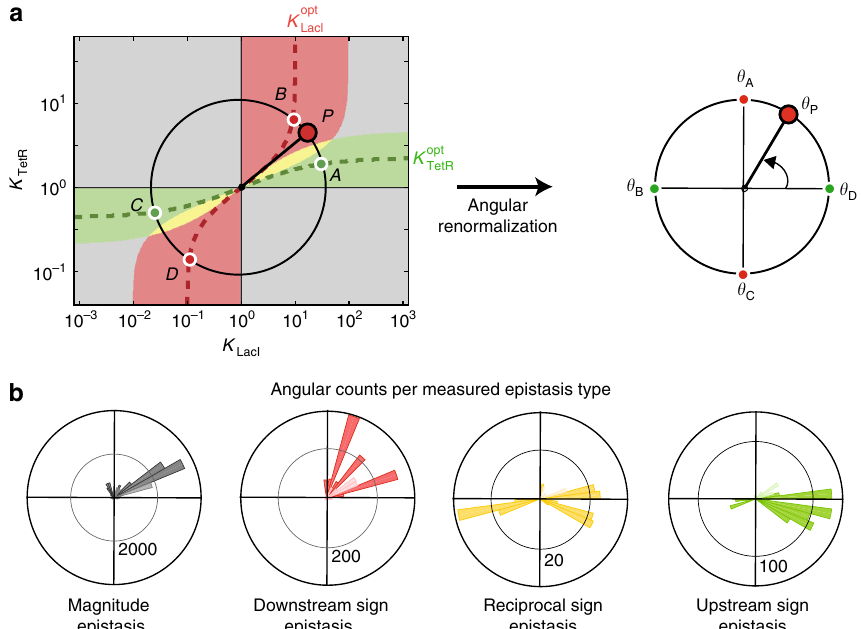
Fig. 4 Epistasis domain structure. The biochemical model and epistasis analysis (Fig. 3) suggests a radial epistasis domain structure centred at the optimum, with e.g. downstream sign epistasis (red) in a single domain towards the top and bottom, upstream sign epistasis (green) towards the right and left and reciprocal sign epistasis (yellow) in between (see a ). Here, we test whether the empirical data are consistent with the domain structure. a Angle normalisation scheme, which can be seen as straightening the dashed lines. More speci fi cally, for any point P , the angular coordinates α A , α B , α C and α D on the black circle passing through P are the intersections with the parameterised optima (red and green dashed lines). These angles are normalised to respectively θ A ¼ 0, θ B ¼ π = 2, θ C ¼ π and θ D ¼ 3 π = 2. The normalised angle θ P for point P is interpolated linearly between these angles. b Normalised angular histograms of epistasis counts for the empirical data (Fig. 1), aggregated overall input ranges, for all possible initial and fi nal mutants and for all phenotypic parameters. Faded bars: non-signi fi cant counts, p < 0.05 (one-tailed binomial test, Methods section). Upstream and downstream sign epistasis counts (resp. green and red) are grouped in peaks, which is consistent with the radial organisation of domains ( a , left). Note that empirical data does not cover the full phenotype space, and hence some angles (e.g. bottom right) are less represented in the data. Some deviations are observed, such as the yellow peak towards the bottom